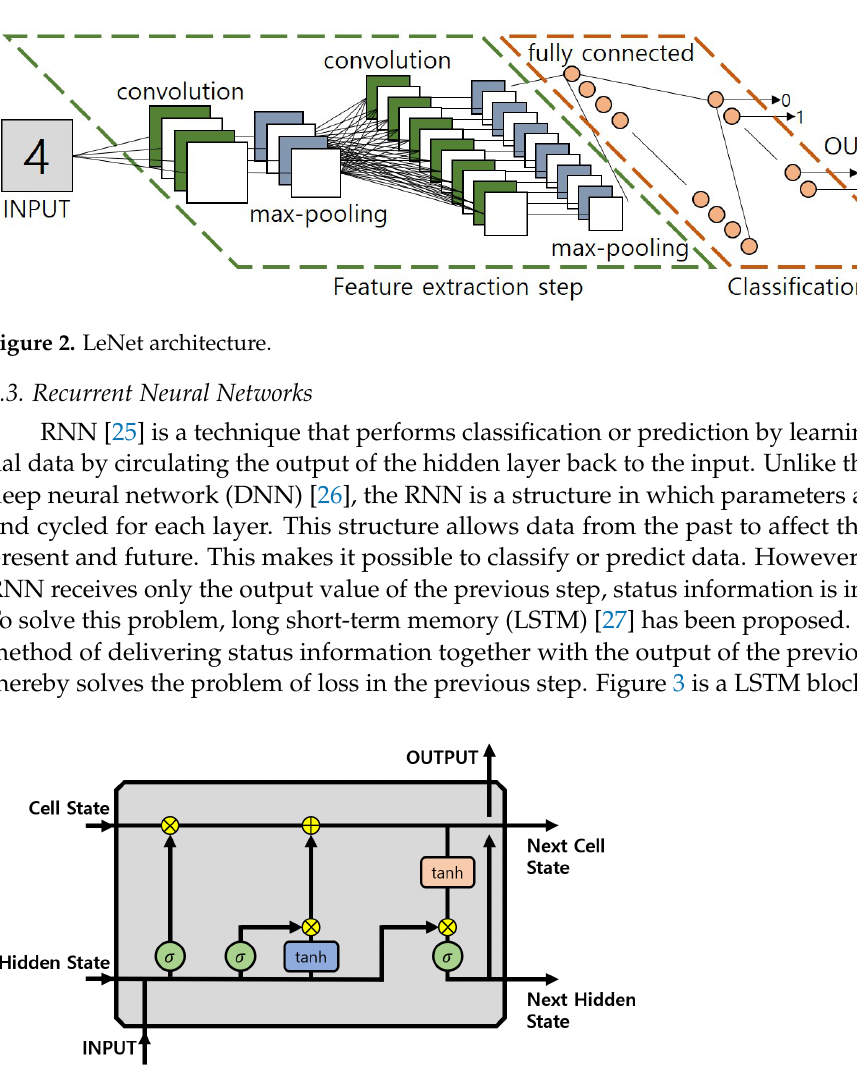
Figure 3. LSTM block diagram.